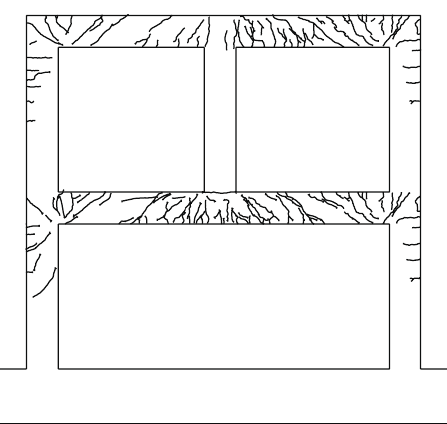
Figure 8: Crack pattern of model frame.